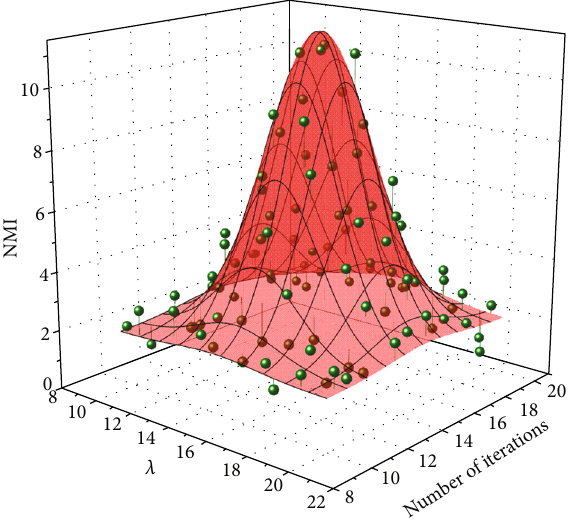
Figure 7: The e ff ect of λ on the clustering e ff ect.